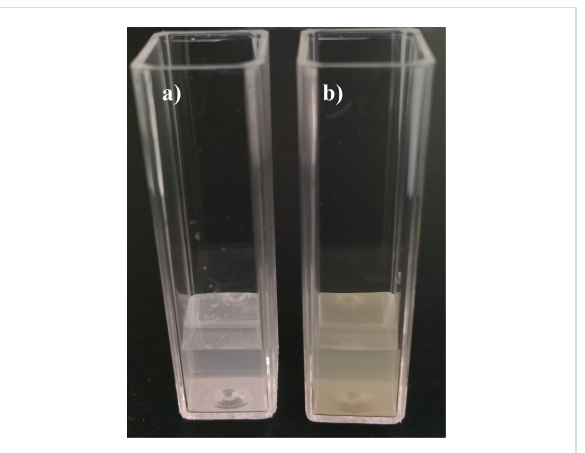
Figure 1: Suspensions of native BNNTs (a) and P(AA- co -FA)-functio- nalized BNNTs (b) obtained at a concentration of 1 mg/mL in distilled water after 2 min of sonic bath treatment.